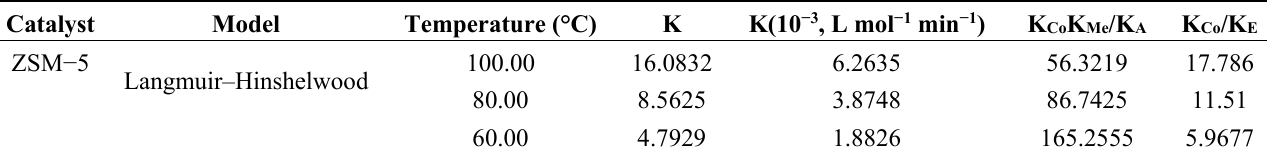
Table 4. Rate constants and Equilibrium constant for Langmuir–Hinshelwood model. Catalyst